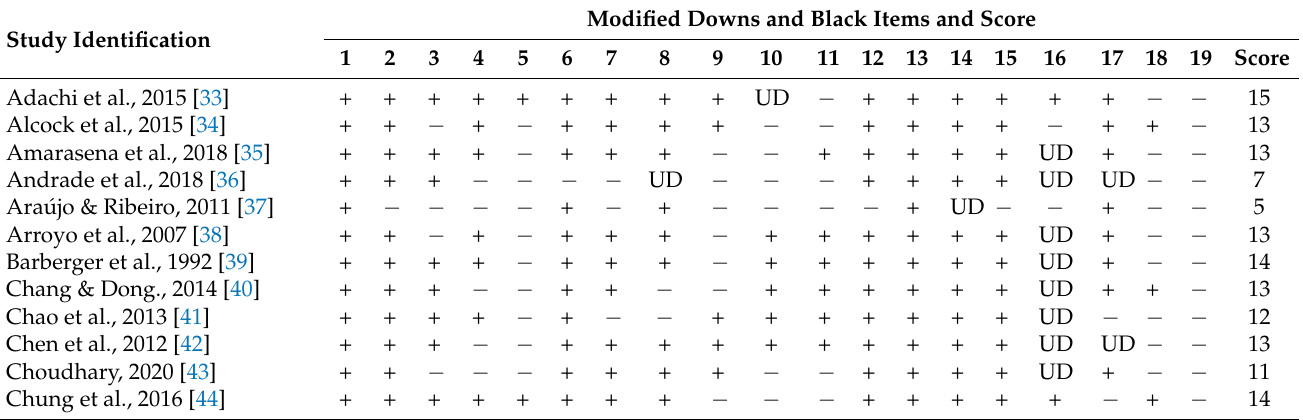
Table 1. Scores of the methodological quality assessment, by the Modified Downs and Black scale, for the included studies (UD—Unable to determine).